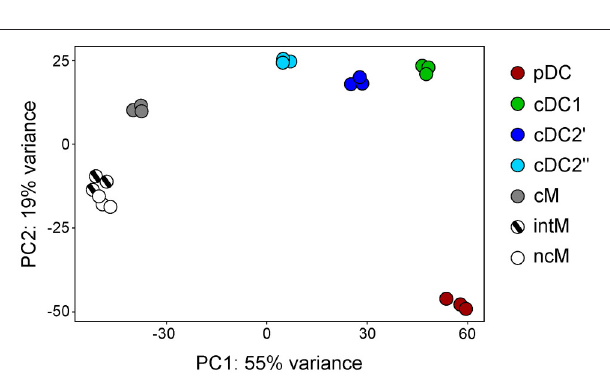
FIGURE 5 | First two axes from a principal component analysis (PCA). High-throughput sequencing was performed on RNA isolated from sorted DC and monocyte subsets and the 500 most variable genes across all samples were included in the PCA. Each dot represents data of one individual animal.